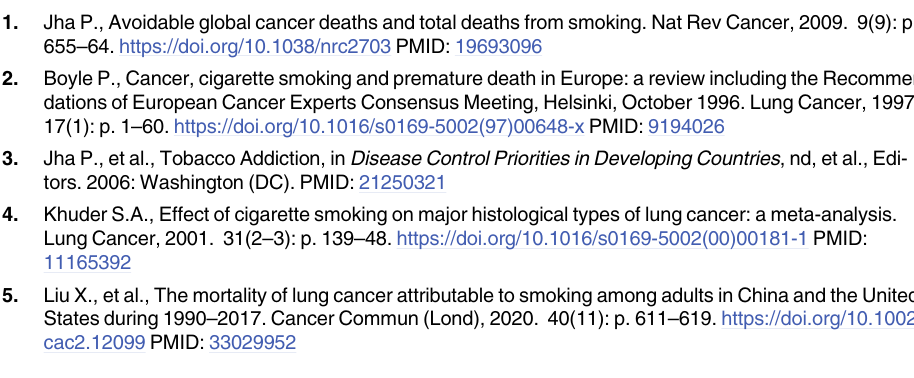
S1 Table. Description of the selected